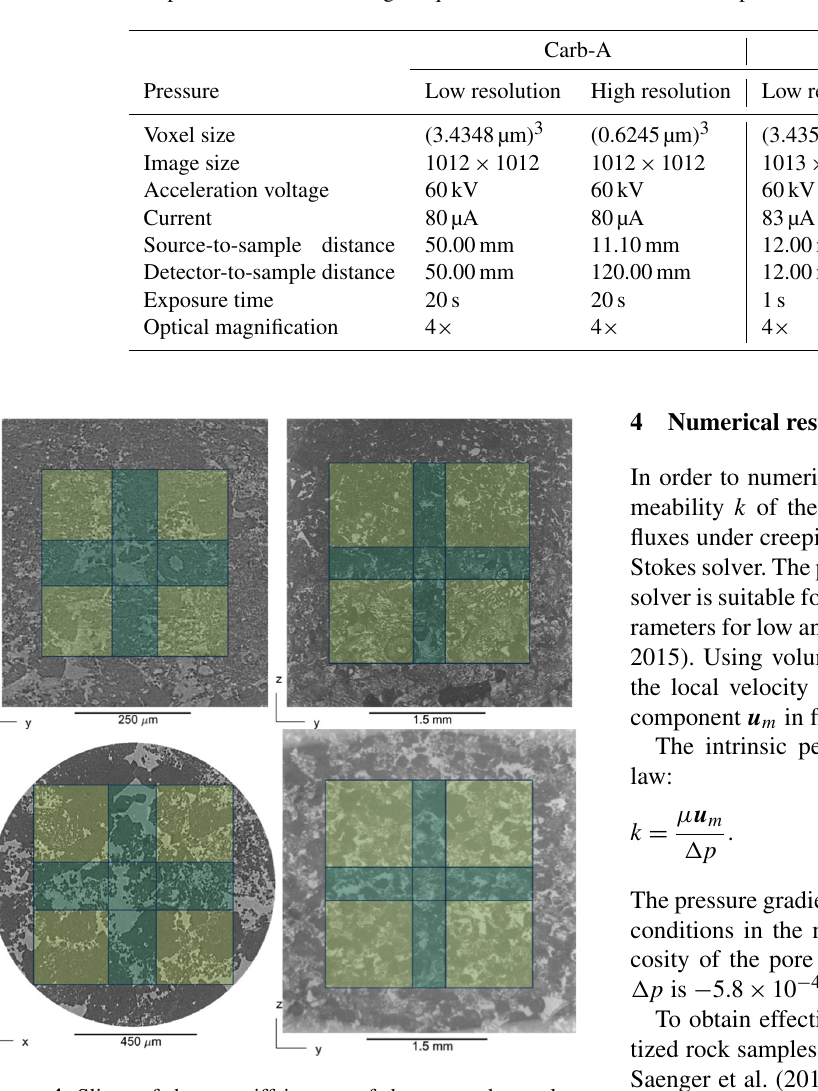
Table 3. CT scanner parameters used for image acquisition of the two carbonate samples. Sample abbreviations are explained in Table 1.